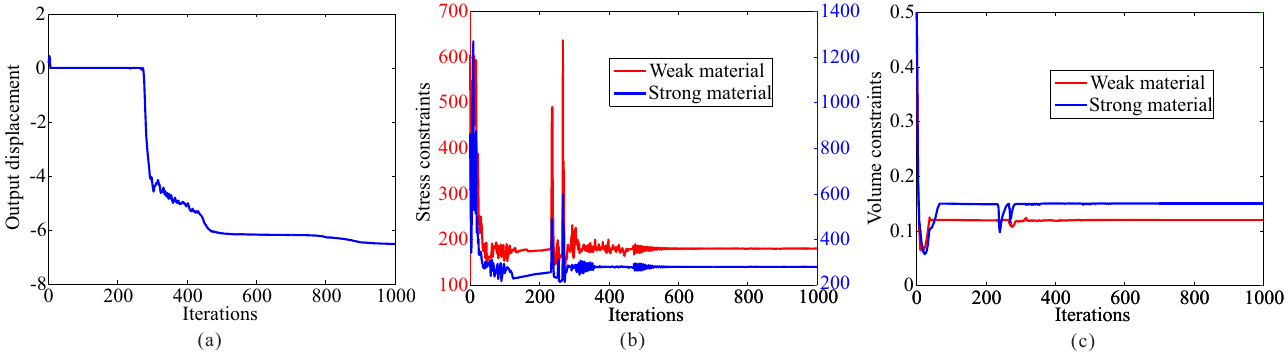
Figure 9. The convergence history for topological design of multi-material compliant gripper with global stress constraints ( σ ∗ = 180 MPa, σ ∗ = 280 MPa). ( a ) Output displacement; ( b ) stress constraints; ( c ) volume